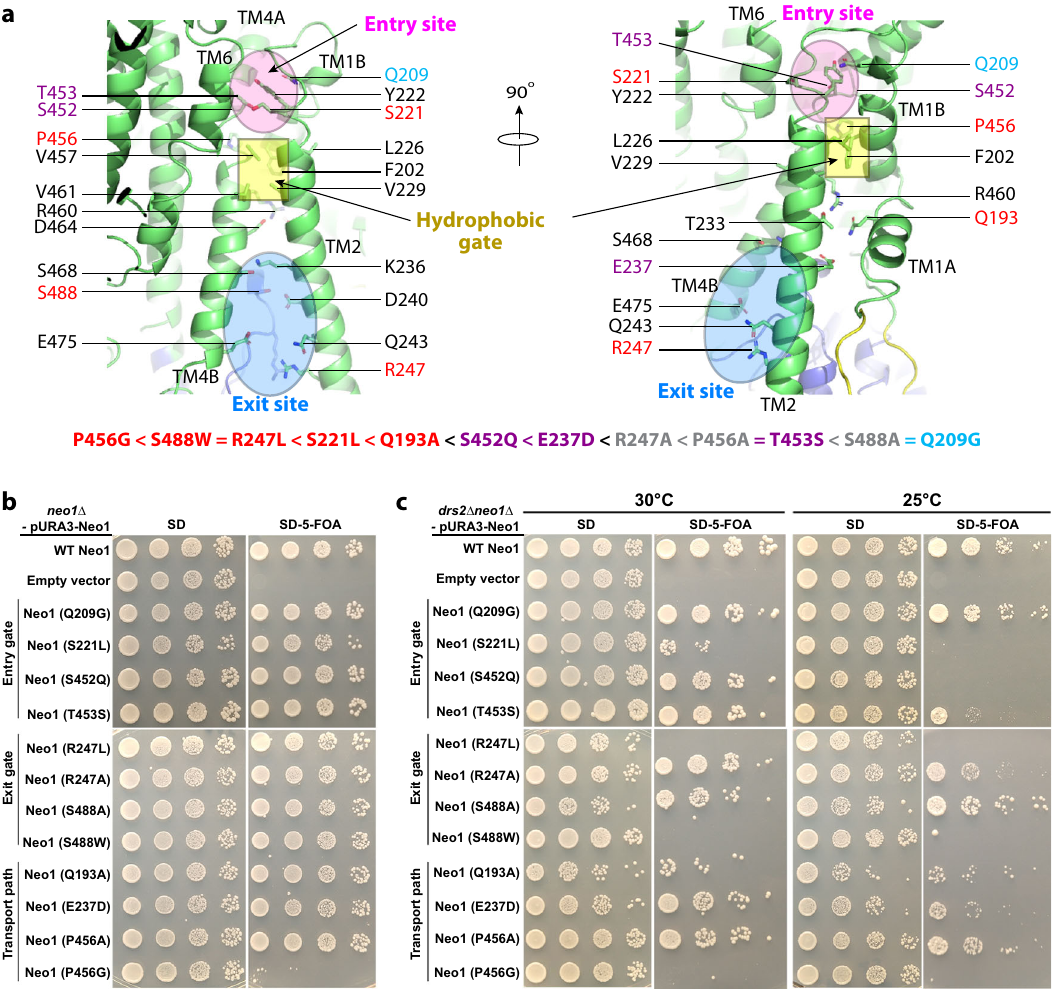
Fig. 4 Mutagenesis of the substrate path. a Putative substrate transport path of Neo1. Cartoon view of the substrate-transporting channel in the Neo1 structure with the residues lining the path shown as sticks. The individual Neo1 mutational effects based on growth phenotypes of neo1 Δ ( b ) and neo1 Δ drs2 Δ ( c ) strains are summarized at the bottom of ( a ) with a color scheme of red (severe), purple (mild), and cyan (nearly normal). Strains on the SD medium expressed both WT and mutant variants of Neo1, but SD + 5-FOA medium eliminated WT Neo1 expressed from the URA3 -marked plasmid. Colony size on the 5-FOA medium indicates how well the Neo1 variants support